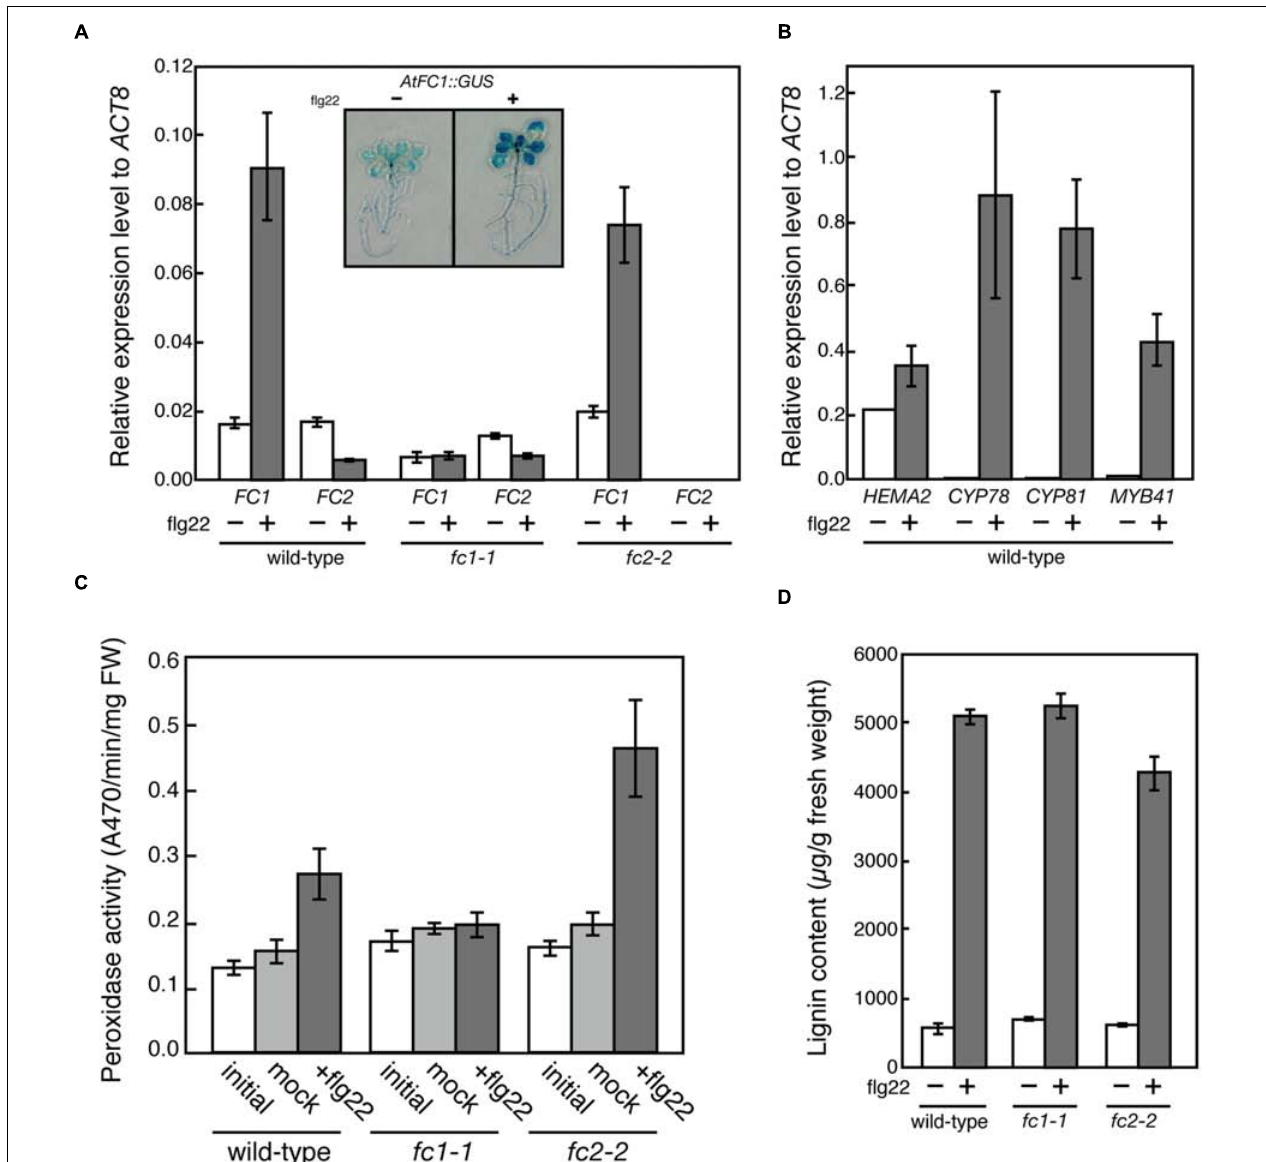
FIGURE 8 | flg22-dependent induction of FC1. (A) qRT-PCR analysis of FC1 and FC2 in wild-type (WT), fc1-1 , and fc2-2 treated with 1 µ g ml − 1 flg22 for 6 h after 5 days of culture. Inset is photograph of GUS staining of FC1::GUS line treated with or without flg22. (B) qRT-PCR analysis of stress-responsive genes ( HEMA2 , CYP78 , CYP81 , and MYB41 ) in wild-type treated with 1 µ g ml − 1 flg22 for 6 h after 5 days of culture. Values are presented as the fold difference from the flg22-untreated wild-type ACTIN8 gene. Bars indicate SEM from three independent experiments. (C) flg22-dependent changes of peroxidase activities. Rosette leaves of 27-day-old seedlings were vacuum infiltrated with or without 0.5 µ g ml − 1 flg22 in the presence of 0.001% Triton X-100. After 24 h incubation, peroxidase activities were measured by using guaiacol as substrate. (D) Quantification of stress-inducible lignin of wild-type (WT), fc1-1 , and fc2-2 seedlings treated with or without 1 µ g ml − 1 flg22 for 3 days after 3 days of